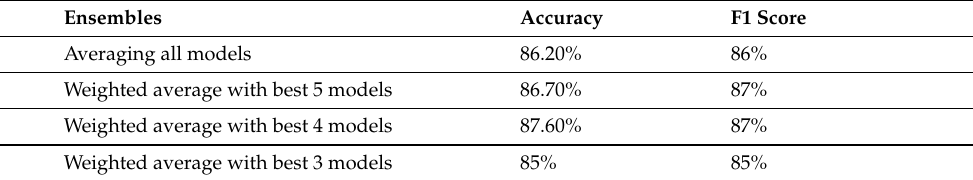
Table 20. Ensembles for superclass